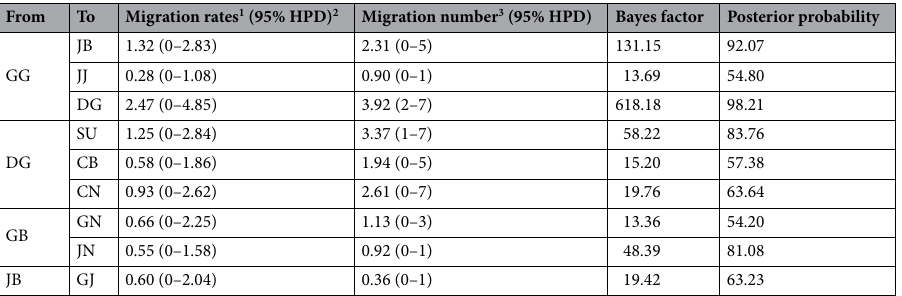
Table 2. Migration rates, migration number, Bayes factor, and posterior probability of spread of the Kor- O1 subgroup in South Korea. Only well-supported viral migrations (posterior probability > 0.5 and Bayes factor > 3) are displayed in this table. GG Gyeonggi-do, JB Jeollabuk-do, JJ Jeju-do, DG Daegu, SU Seoul, CB Chungcheongbuk-do, CN Chungcheongnam-do, GB Gyeongsangbuk-do, GN Gyeongsangnam-do, JN Jeollanam-do, GJ Gwangju. 1 Actual migration rates were calculated as rate × indicator. 2 95% HPD, 95% height posterior density. 3 Number of migrations among regions in phylogenetic tree (Markov jumps) were estimated using stochastic mapping techniques implemented in the BEAST package.